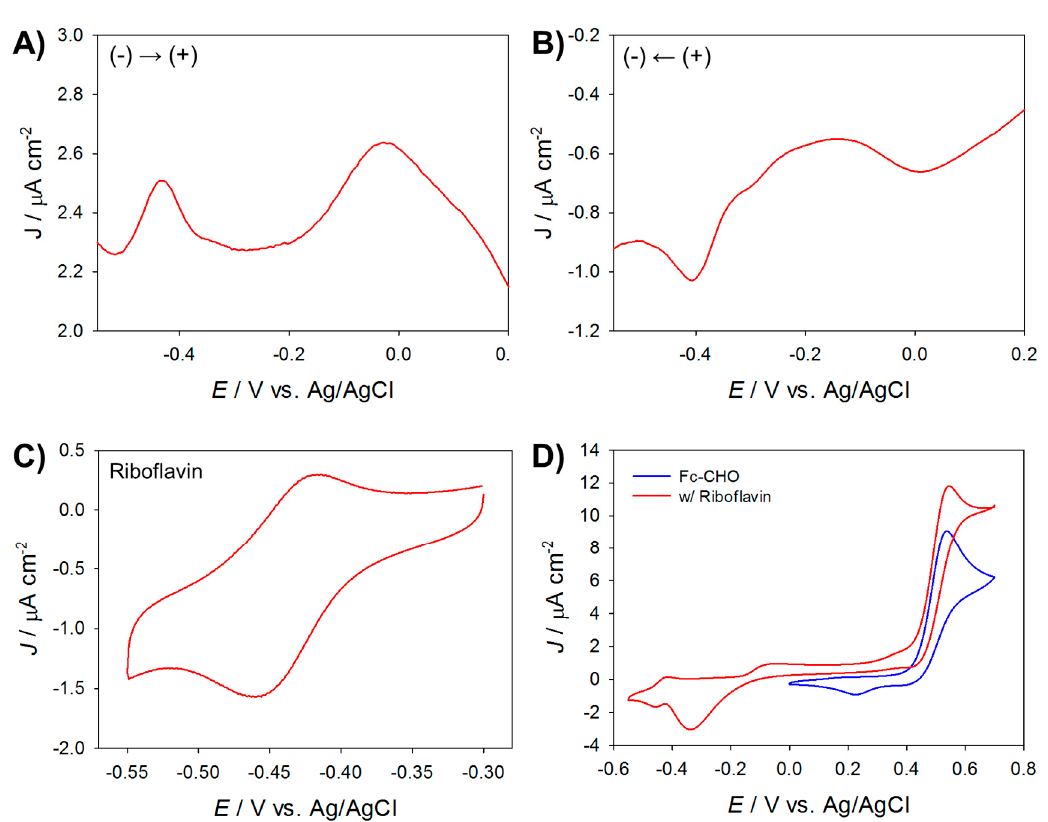
Figure 3. Di ff erential pulse voltammetry (DPV) graphs ( A ) from negative to positive potentials (oxidation) and ( B ) from positive to negative potentials (reduction) of glassy carbon electrodes in cell-free medium after 72 h C. glutamicum growth. ( C ) Cyclic voltammogram of riboflavin (2 µ M) and ( D ) ferrocenecarboxaldehyde (Fc-CHO, 100 µ g mL − 1 ) in 0.1 M sodium phosphate bu ff er (pH 7.0). Scan rate, 10 mV s − 1 .